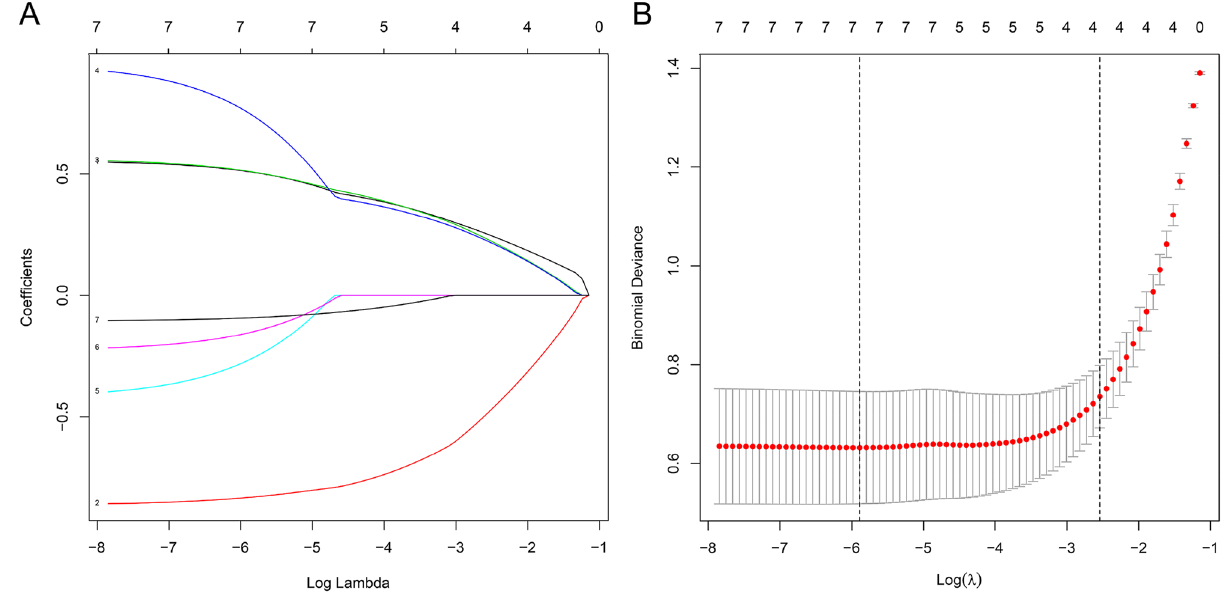
Figure 6. Lasso regression removes collinearity to identify 7 hub genes.